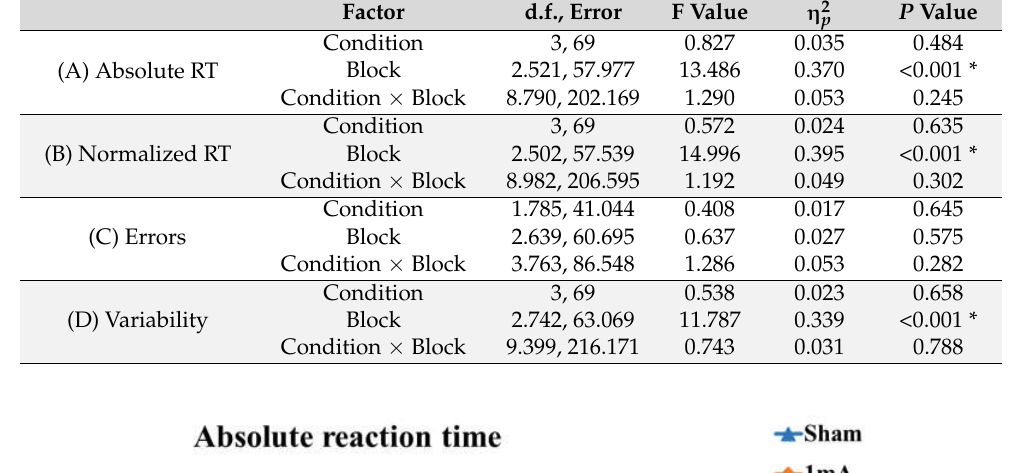
Table 1. Effect of tDCS on M-SRTT. Results of the repeated measures ANOVAs for the M-SRTT: (A) absolute RTs, (B) normalized RTs, (C) number of errors, and (D) variability of absolute RTs are shown. Asterisks indicate significant results ( p < 0.05). d.f. = degrees of freedom, η 2 p = partial eta squared. Factor d.f., Error F Value η 2 p P Value